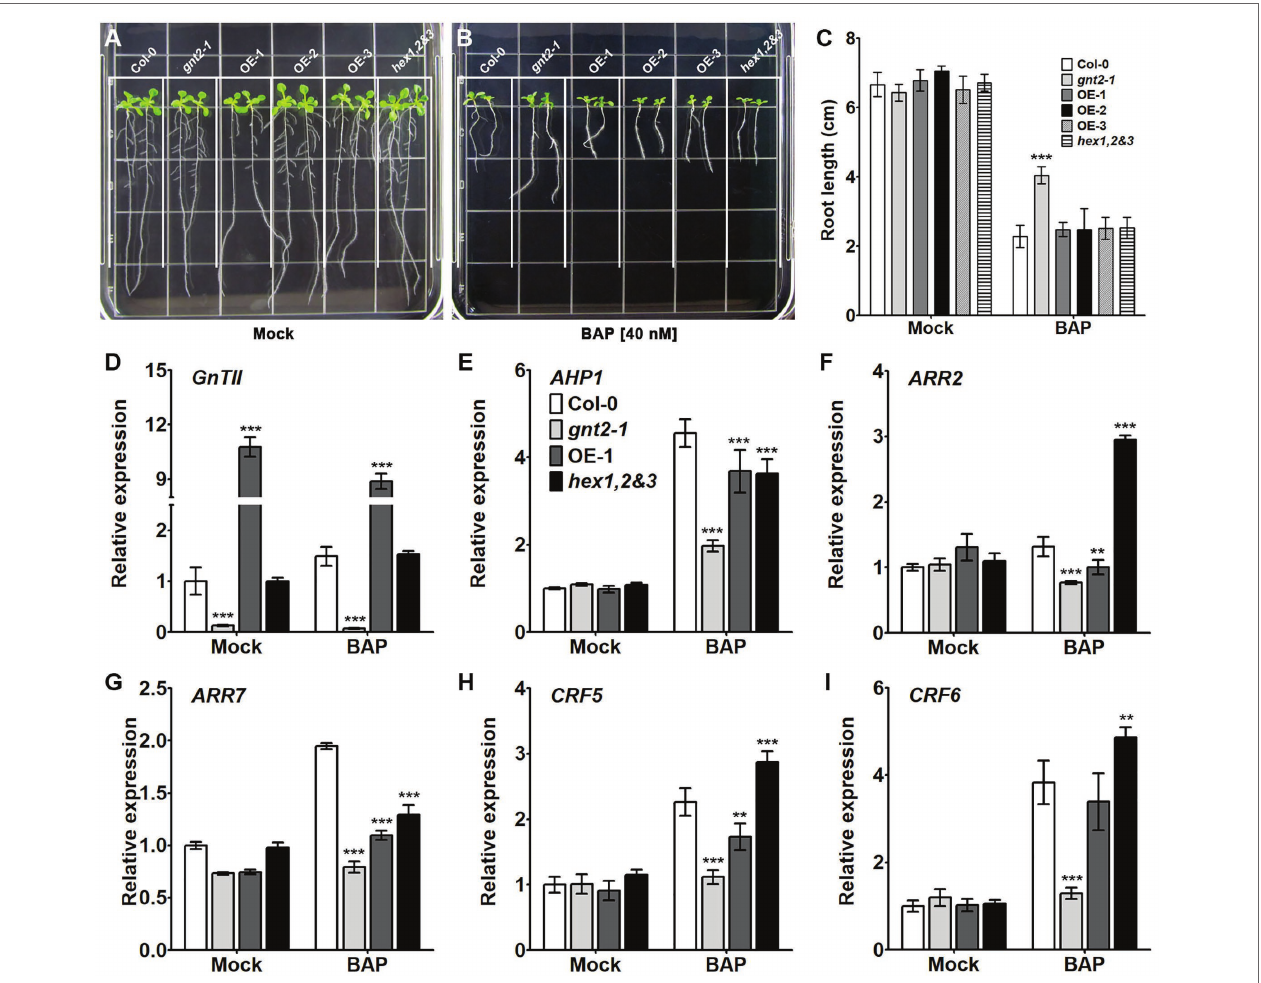
FIGURE 6 | The gnt2-1 mutant exhibits partial cytokinin insensitivity. (A,B) Representative photographs of Arabidopsis seedlings grown vertically on tissue culture plates containing solidified MS medium (A) or MS medium supplemented with 40 nm BAP (B) , taken 12 day after plating. The grid on the square plate is 18 × 18 mm. (C) Relative root length of Col-0, gnt2-1 , OE-1, OE-2, OE-3, and hex1,2&3 plants grown in the absence or presence of BAP. (D–I) . Expression of cytokinin-related genes in Col-0, gnt2-1 , OE-1, and hex1,2&3 plants. The relative expression of mRNAs encoding the cytokinin-related genes was analyzed by qPCR. The experiment was performed independently three times (three biological replicates) and normalized with respect to β -TUBULIN expression. Data represent mean ± SEM of three independent experiments. Asterisks indicate statistically significant differences (* p < 0.05, ** p < 0.01, and *** p < 0.001) as determined by two-way